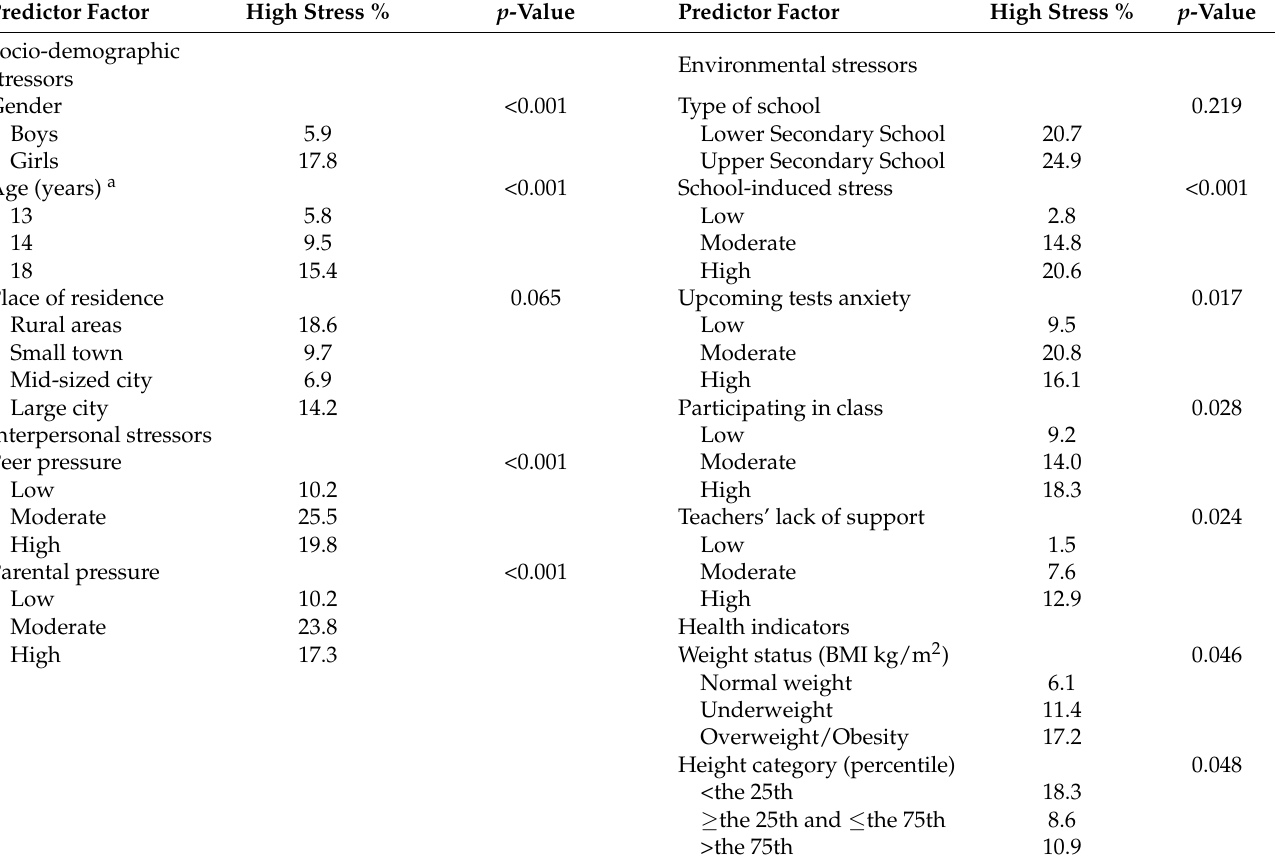
Table 3. Prevalence of high perceived stress level experienced by adolescent students across levels of candidate predictor factors. Predictor